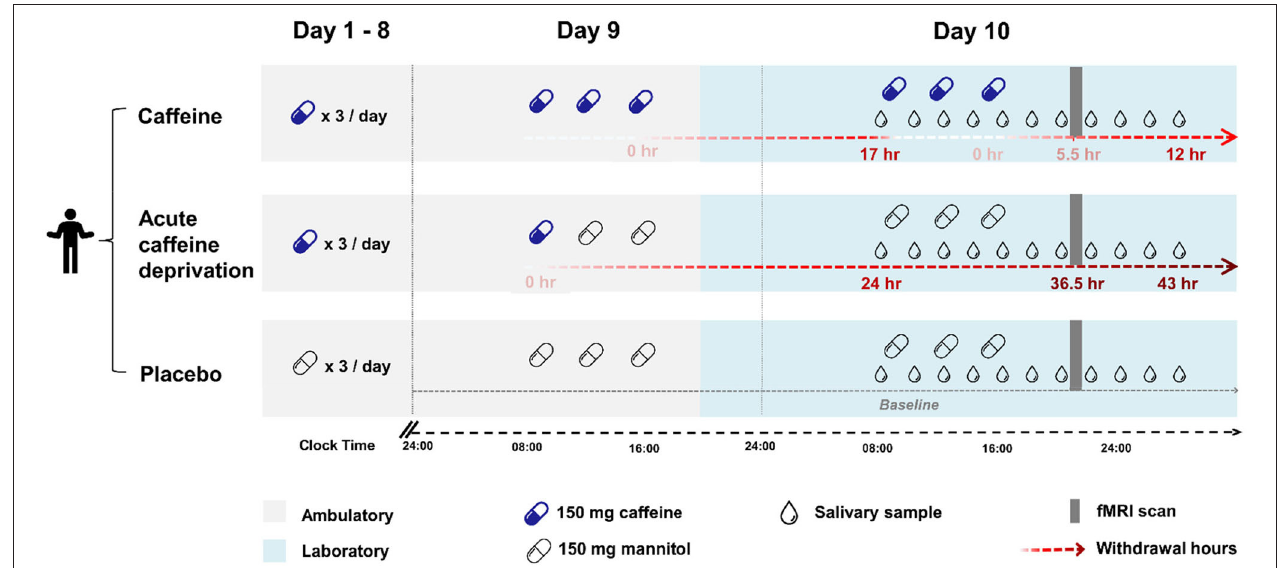
FIGURE 1 | An overview of the study design. Each condition consisted of 9 ambulatory days (grey shading) and a subsequent 21-h laboratory measurement starting in the evening of day 9 (blue shading). The timing of caffeine or placebo intake is indicated by capsules (blue: caffeine, transparent: placebo), the timing of saliva collection to measure caffeine and paraxanthine levels is indicated by drops. Top: Caffeine condition. Caffeine capsules (150mg caffeine) × 3 times/ day (at 45min, 4h, and 8h after waking up) were administered throughout the 10 days. Saliva was collected repeatedly during the laboratory stay from right before the first capsule until 12h after the latest caffeine intake. The MRI scan (grey bar) took place at 5.5h after the latest caffeine intake. Middle: Acute caffeine deprivation. Caffeine capsules (150mg caffeine) × 3 times/ day was administered for 8 days, followed by a switch to placebo capsules on day 9. Saliva was collected between 24 and 43h after the latest caffeine intake. The MRI scan was scheduled at 36.5h after the latest caffeine intake, a time window when strong withdrawal symptoms are often expressed ( 25). Bottom: Placebo condition. Placebo capsules (150mg mannitol) × 3 times/ day were administered throughout the ambulatory and laboratory days. Saliva was collected at baseline through the entire laboratory phase at the corresponding time points as in the other two conditions. The MRI scan was scheduled at the same time of day as in the other two conditions.